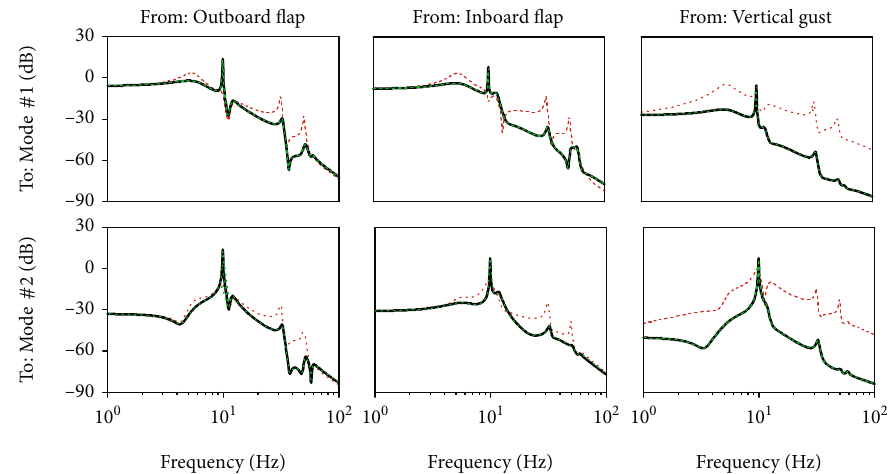
∞ = 30m/s ) and the interpolated model using